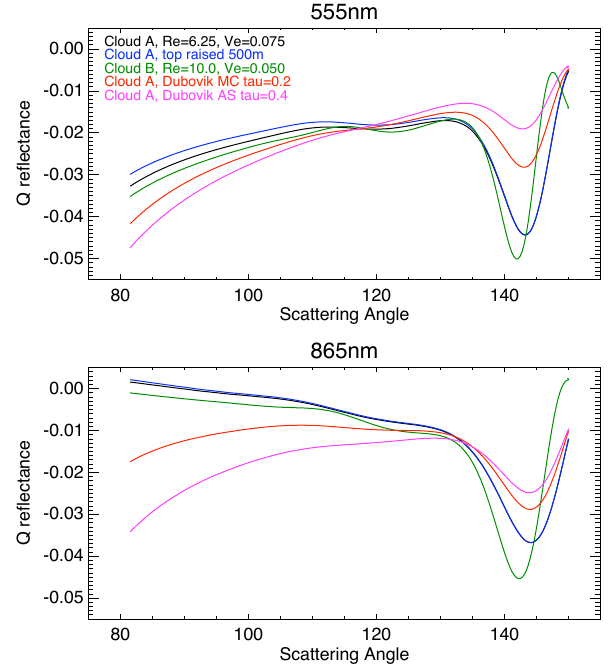
Fig. 1. The sensitivity of multi-angle polarimetry to cloud and aerosol optical properties is demonstrated in this figure. Black lines are ( R Q ) in the scattering plane for a simulated cloud (type A) with an optical thickness of 20.0 and a vertically uniform droplet size distribution of ( r e =6.25µm), ( v e = 0 . 75) from the ground to 480m. The top panel is reflectance at 0.555µm, while the bot- tom panel is reflectance at 0.865µm. Blue lines are reflectance from the cloud when the top has been raised by 500m. Green lines are the reflectance of a cloud containing different droplet sizes, (( r e = 10µm), ( v e = 0 . 05)). Red and magenta lines indicate the re- flectance of a cloud with aerosols above, the former for “Mexico City” type urban aerosols with ( τ( 0 . 555 ) = 0 . 2) and the latter for “African Savann” biomass burning aerosols with an optical thick- ness of ( τ (0.555)=0.4) from Dubovik et al. (2002). All scenes are simulated with a solar zenith angle of ( θ s =45 ◦ ) and a relative az- imuth angle of ( φ =45 ◦